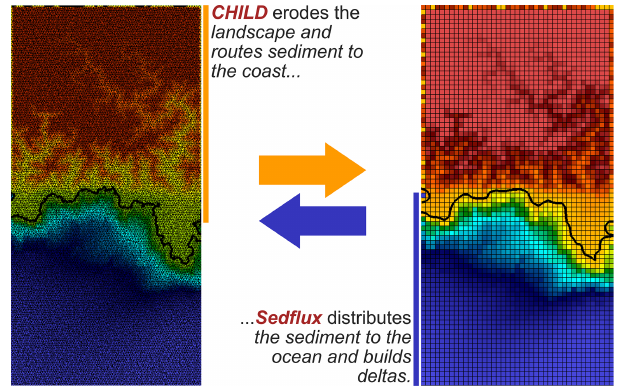
Figure 7. Results of a coupling experiment using the Python Mod- eling Toolkit (pymt). The CHILD model (C++; unstructured mesh) erodes an uplifting landscape and transports sediment to the coast. Sedflux (C; structured rectilinear grid) sends sediment from the coast to the ocean as surface plumes where it then settles onto the seafloor. As sediment accumulates on the seafloor, deltas begin to form and this new landscape is sent back to CHILD, completing the two-way coupling between these two pymt